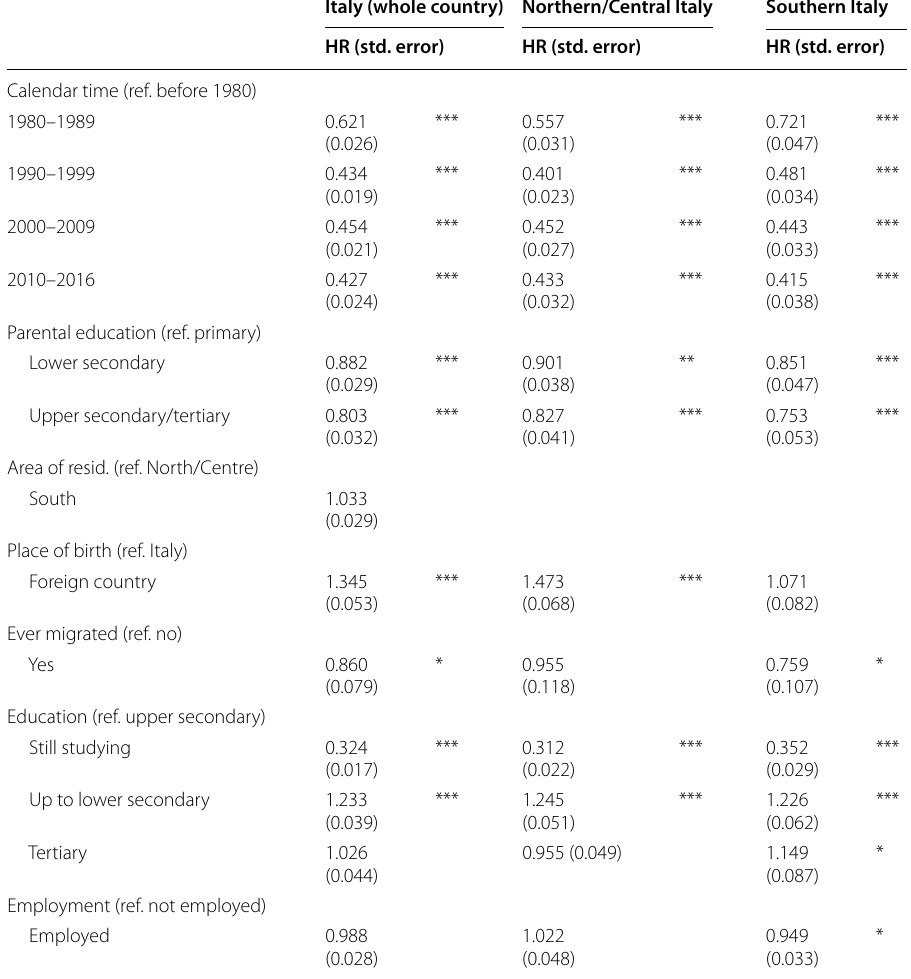
Table 1 Employment status and transition to motherhood. Cox models, HRs are reported with standard errors in